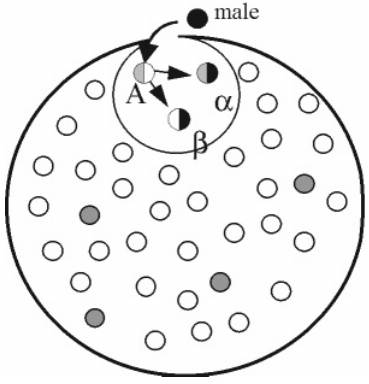
Figure 1 - Genetic relationship of individual female A with its descendents a and b . According to the genetic frequency of the neighboring population, female A has greater aggregated relatedness with a than with b . The pat- terns refer to the genotype of the individuals under consideration. Black = Male’s allele; white = allele a y ; gray = mutant allele a x